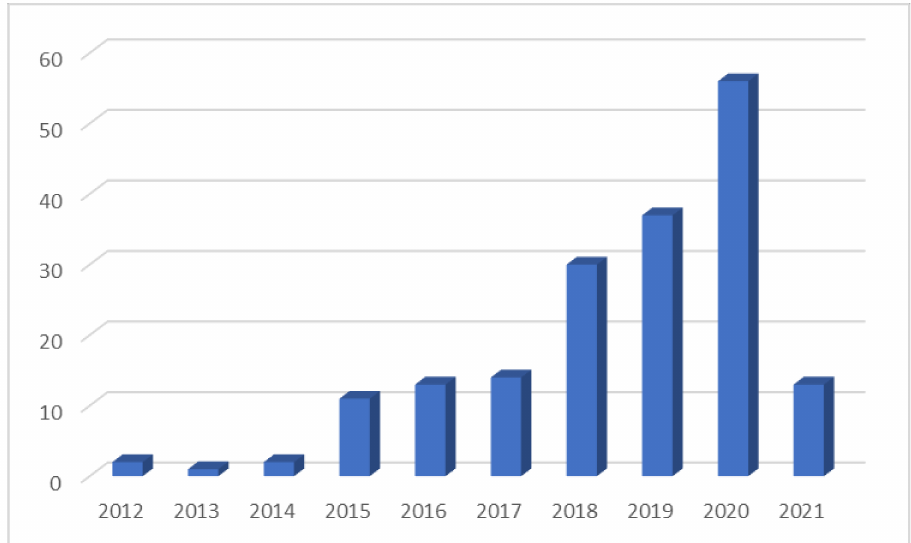
Figure 6. Number of documents per year of publication.